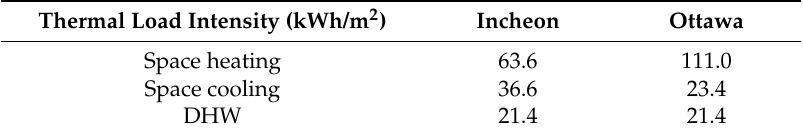
Table 5. Annual space heating, space cooling and domestic hot water load intensity.